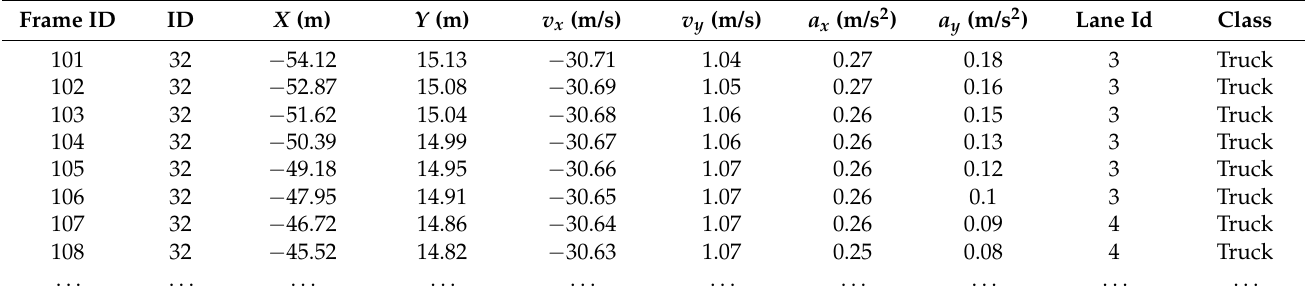
Figure 3. Vehicle track parameters. Table 1. Vehicle running track data (part).